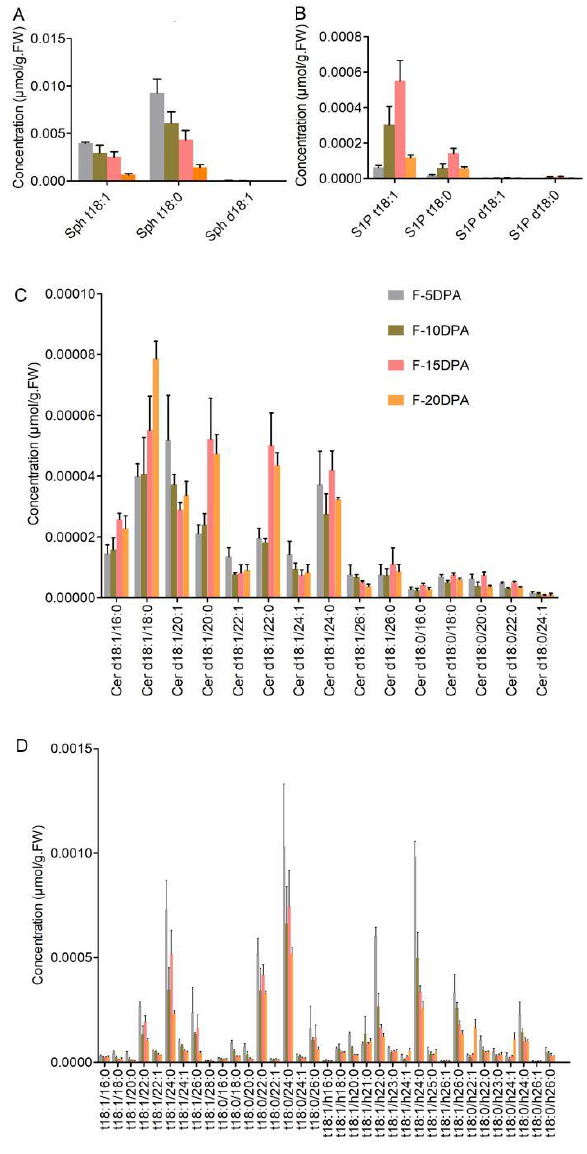
Figure 2. The concentration of simple sphingolipids in cotton fiber cells at four developmental stages. ( A ) The concentration of various molecular species of Sph. ( B ) The concentration of various molecular species of S1P. ( C ) The concentration of various molecular species of Cer. ( D ) The concentration of various molecular species of PhytoCer in cotton fiber cells at four developmental stages. Sph, sphingosines; S1P, sphingosine-1-phosphate; Cer, ceramides. “d18:0/1” indicates that the long-chain bases (LCB) of sphingolipids had w hydroxyl groups (d), 18 carbon atoms, and no or 1 double bond; “t18:0/1” indicates that the LCB had 3 hydroxyl groups (t), 18 carbon atoms, and no or 1 double bond; “16-26:0/1” indicates that the long-chain fatty acid (LCFA) of sphingolipids had 16 to 26 carbon atoms and no or one double bond; and “h16-26:0/1” indicates that the long-chain fatty acid (LCFA) of sphingolipids was a hydroxylated fatty acyl (h) and had 16 to 26 carbon atoms and no or 1 double bond. F-5 DPA, F-10 DPA, F-15 DPA, and F-20 DPA represent fiber cells at 5, 10, 15, and 20 DPA. Each analysis was repeated with three biological replicates.